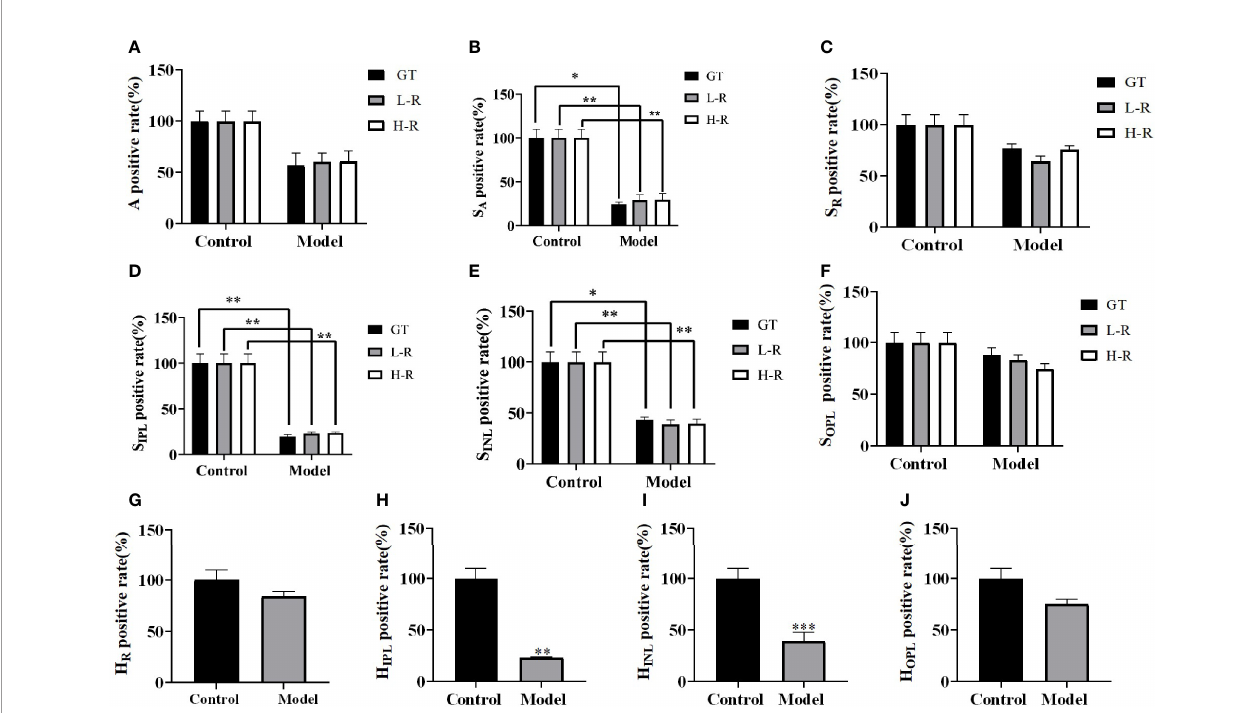
FIGURE 6 | Comparison of the Unet network with arti fi cial interpretation results for full convolutional attentional enhancement. (A) Comparative images of positive retinal ganglion cell numbers in control and model group. (B – F) Comparative images of the positive rate of the retinal layer area in control and model group. (G – J) Comparative images of positive rate of retinal thickness in control and model group. GT is the result of manual interpretation; L-R is the result of low-resolution image AI interpretation; H-R is the result of AI interpretation of high resolution image. The Control group for each method is considered 100% vs. control group: * p < 0.05, ** p < 0.01, *** p <